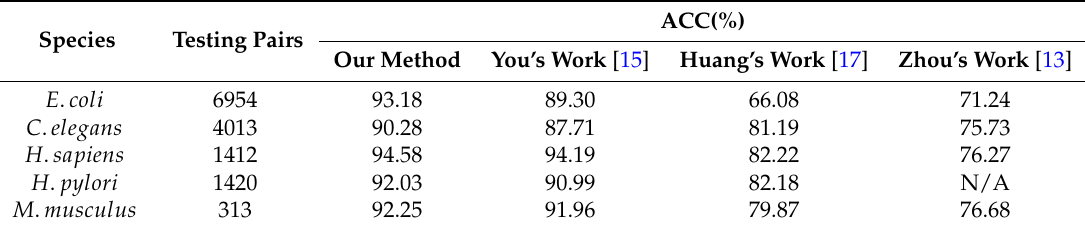
Table 6. Prediction results on five independent species by our proposed method, based on the S . cerevisiae dataset as the training set. N/A means not available.